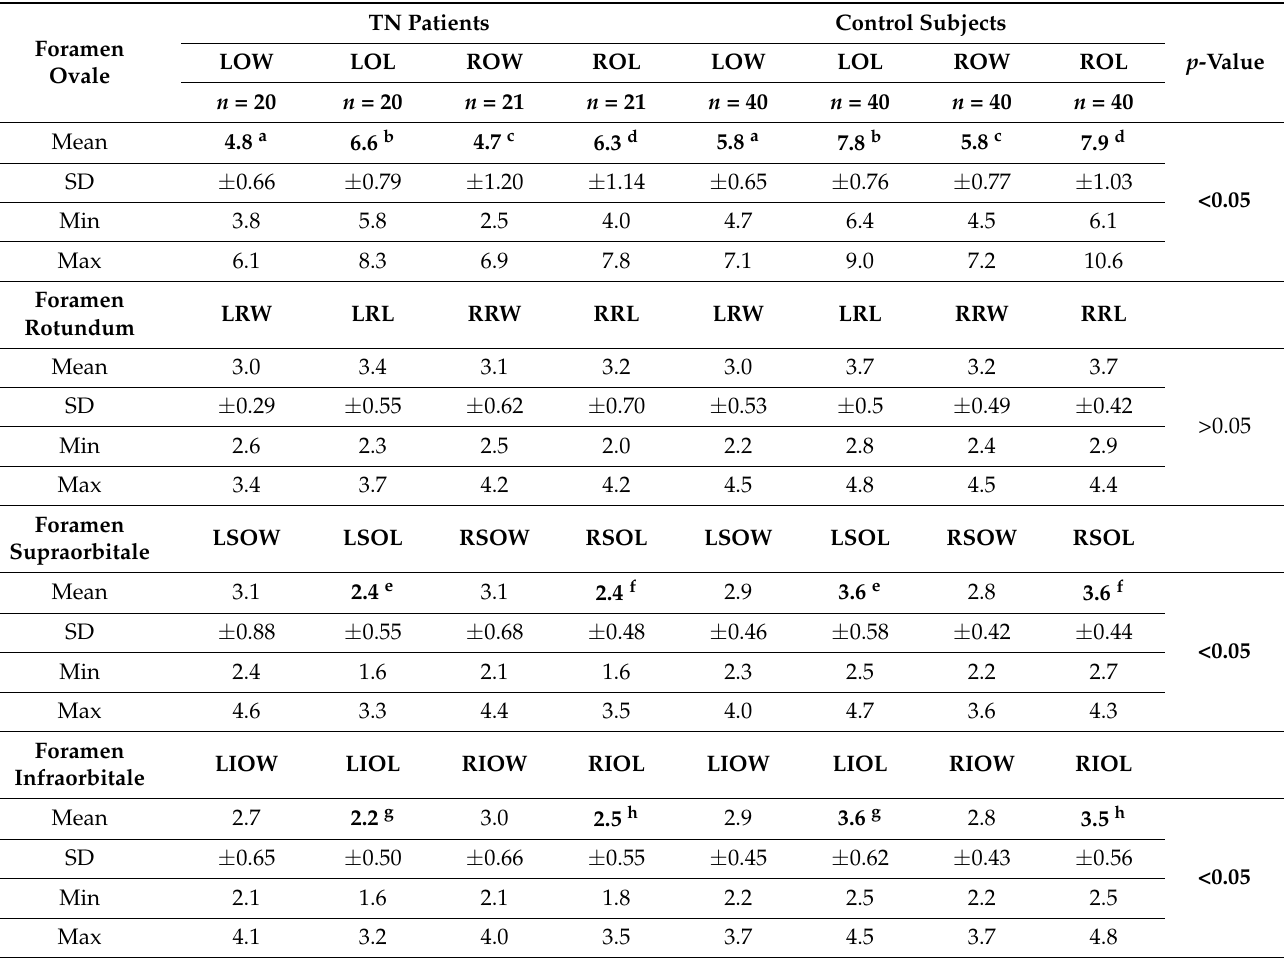
Table 1. The dimensions of the foramen ovale, rotundum, supraorbitale and infraorbitale comparison in trigeminal neuralgia patients and control subjects. The same letters indicate statistical significance, which is less than 0.05.